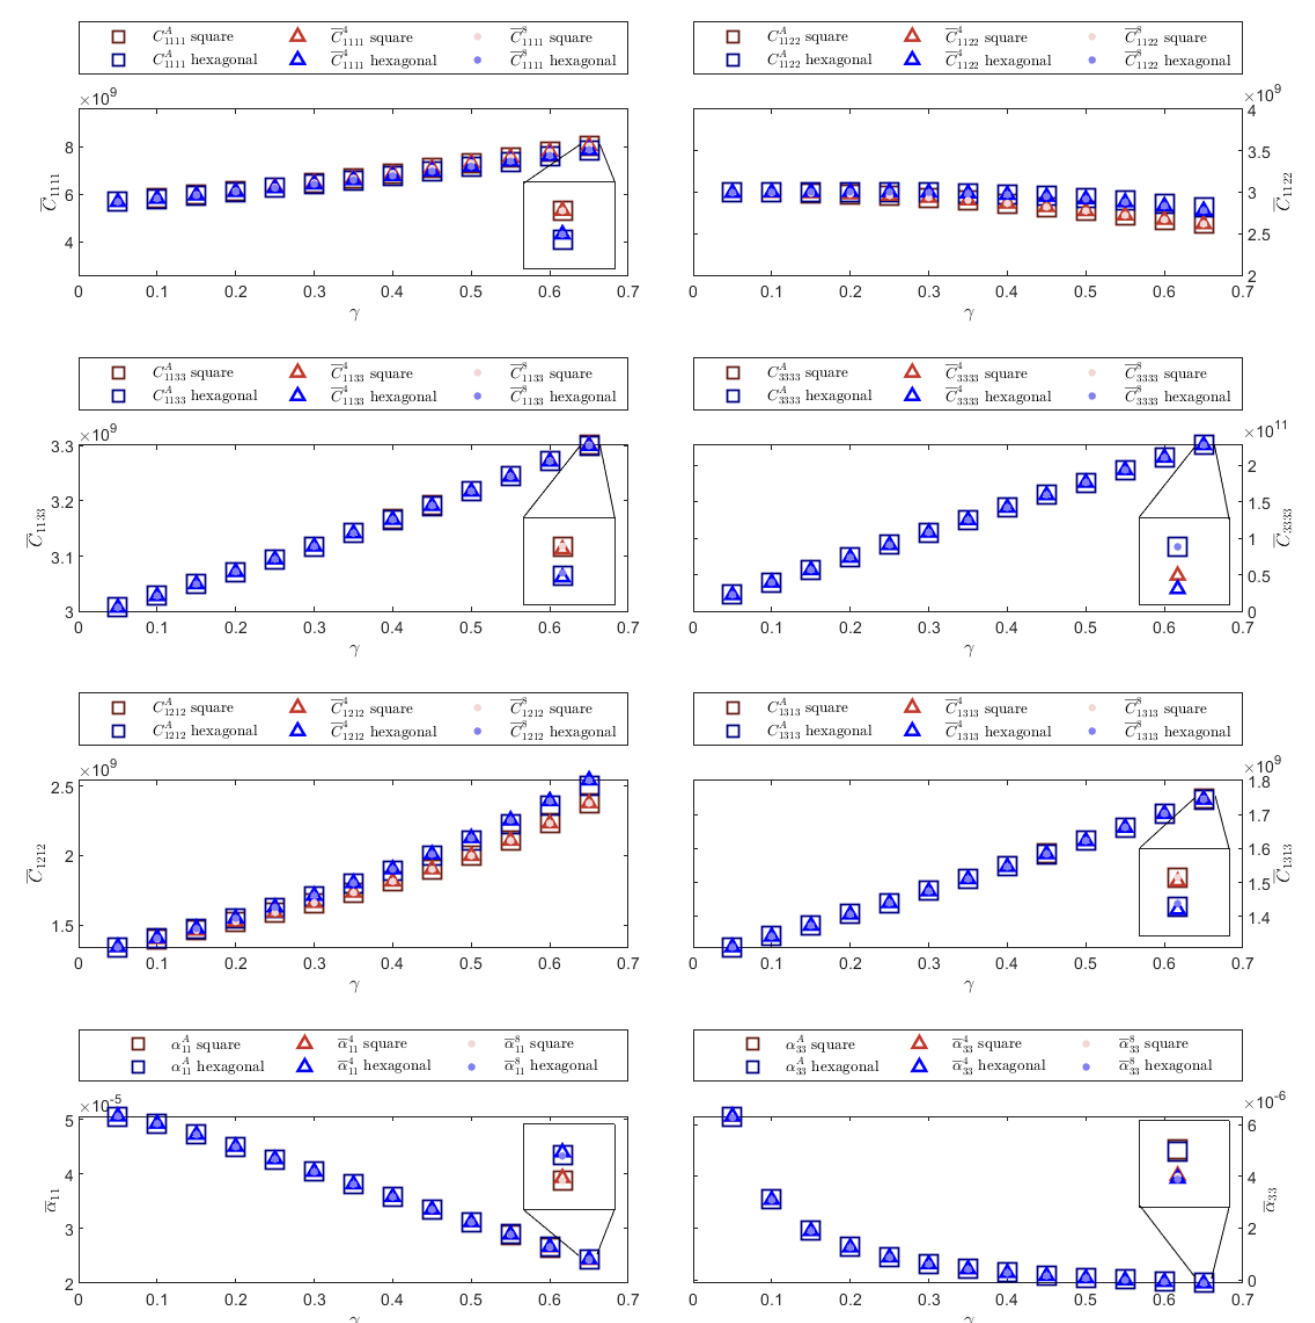
Figure 6. Effective properties for Graphite/Epoxy composite material for square and hexagonal